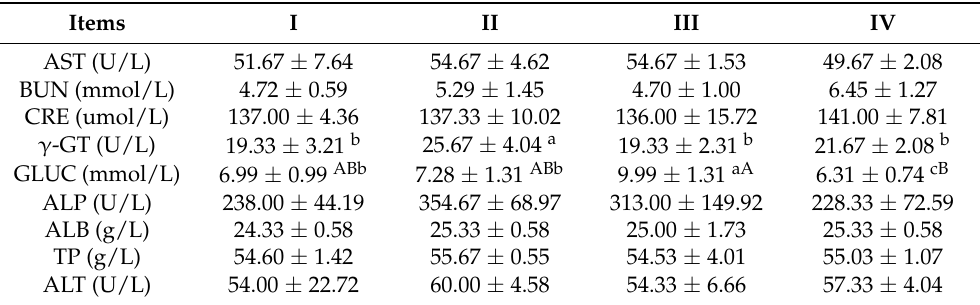
Table 6. Effects of dietary supplementation with different inclusion of SMS-MP on serum biochemical indexes of growing sika deer.